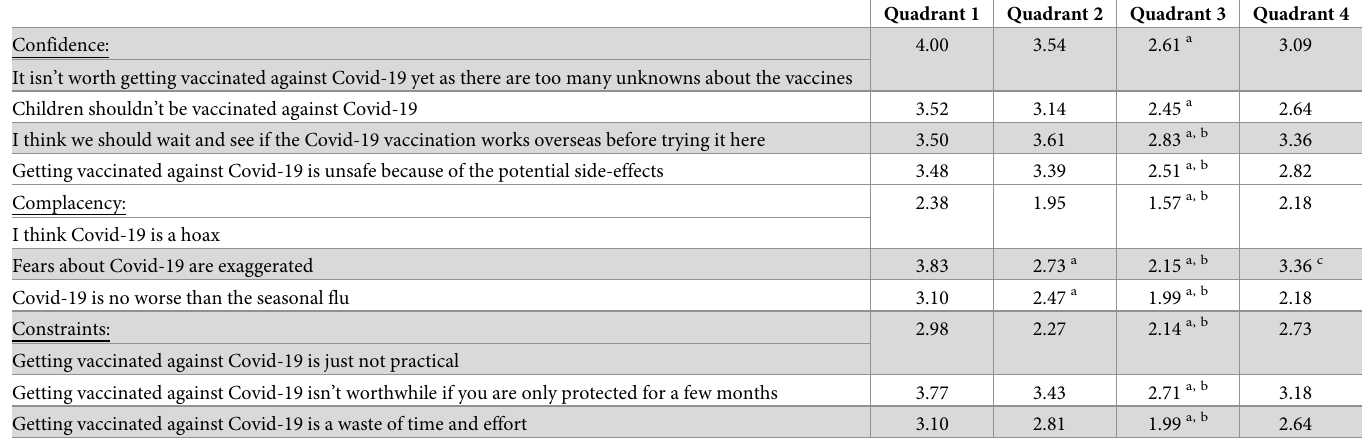
Table 7. I 3 vaccine classification, confidence, complacency, and